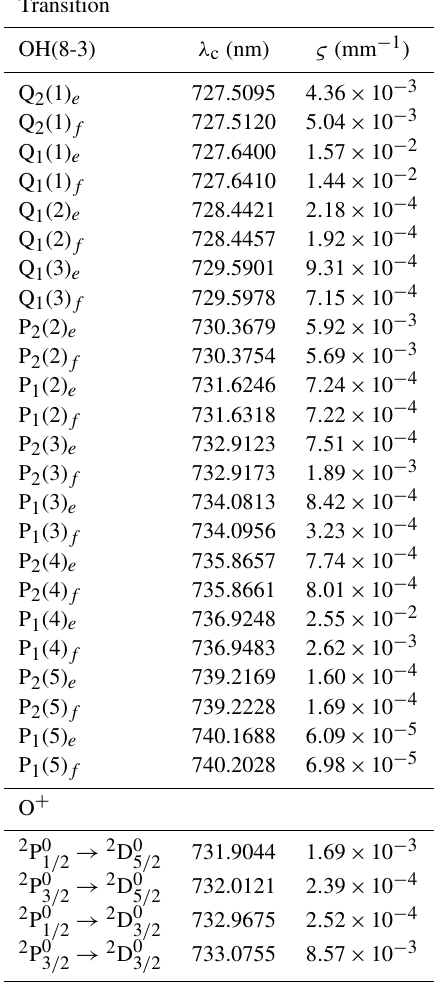
Table 1. Emission lines used in the spectral fit. The line centre wavelengths ( λ c ) are from Rousselot et al. (2000), converted to air wavelengths following Ciddor (1996). Water vapour transmission is given by a function of PWV: t λ = exp ( − ς × PWV ) , with PWV in millimetres.